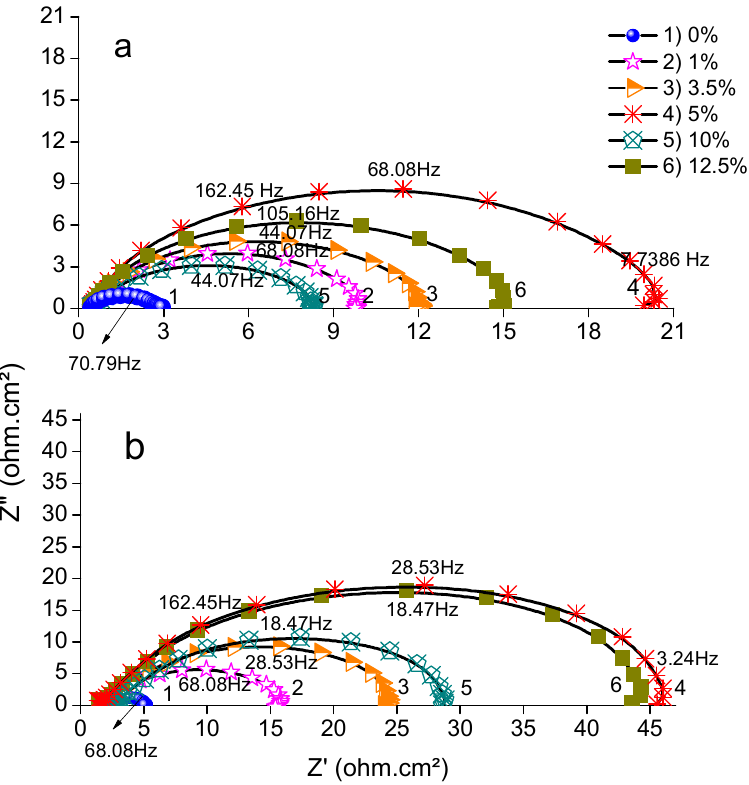
Figure 1. Nyquist plots for Carbon steel in ( a ) 2 M H 2 SO 4 and ( b ) 2 M H 3 PO 4 in the absence and presence of different concentrations of Mahaleb seed extract (ASMS) at 298 °K.